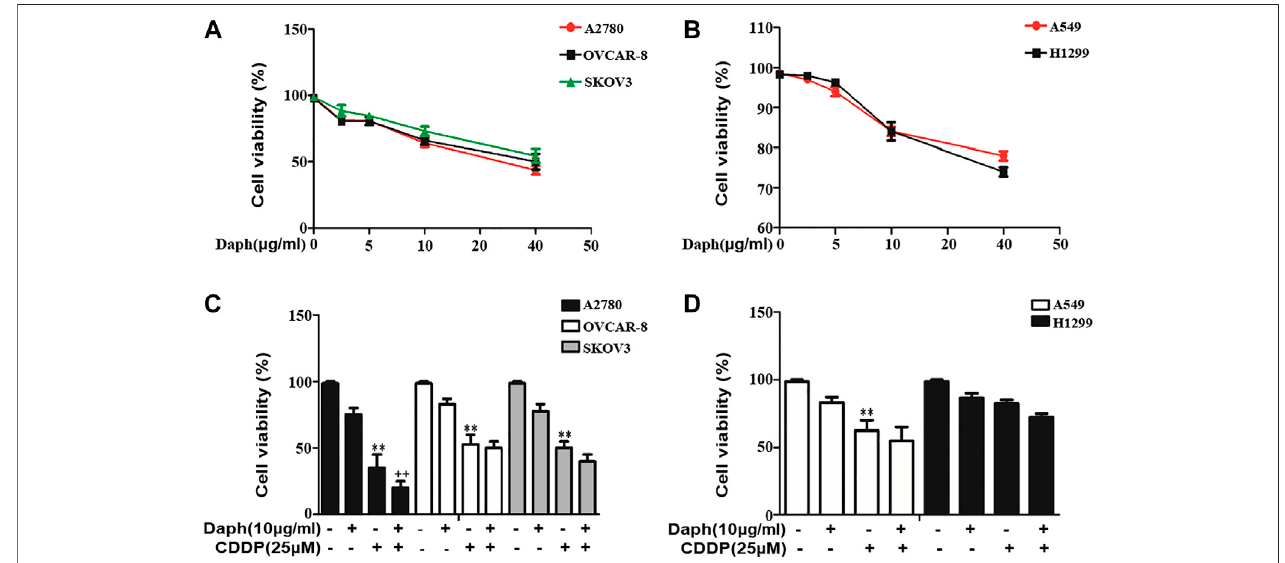
FIGURE11| Daphdidnotcompromisetheanti-canceractivityofCDDPinhumanovariancarcinomacelllinesandtheNSCLCcelllines. (A,B) EffectofDaphonthe cellviabilityofthehumanovariancarcinomacelllineA2780,OVCAR-8andSKOV3andtheNSCLCcelllinesA549andH1299aftertreatmentfor48 h( n (cid:2) 4) (C,D) Effect of Daph (10 μ g/ml, pretreatment for 1 h) on the anti-cancer activity of CDDP (48 h) in the human ovarian carcinoma cell lines A2780, OVCAR-8 and SKOV3 and the NSCLC cell lines A549 and H1299. Data are presented as the mean ± SEM, and are representative of three independent experiments. ** p < 0.01 vs. the control group; ## p < 0.01 vs. the CDDP